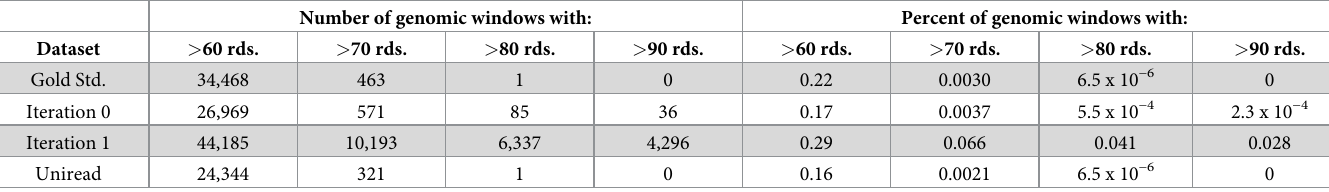
Table 3. Analysis of high-depth regions under SmartMap